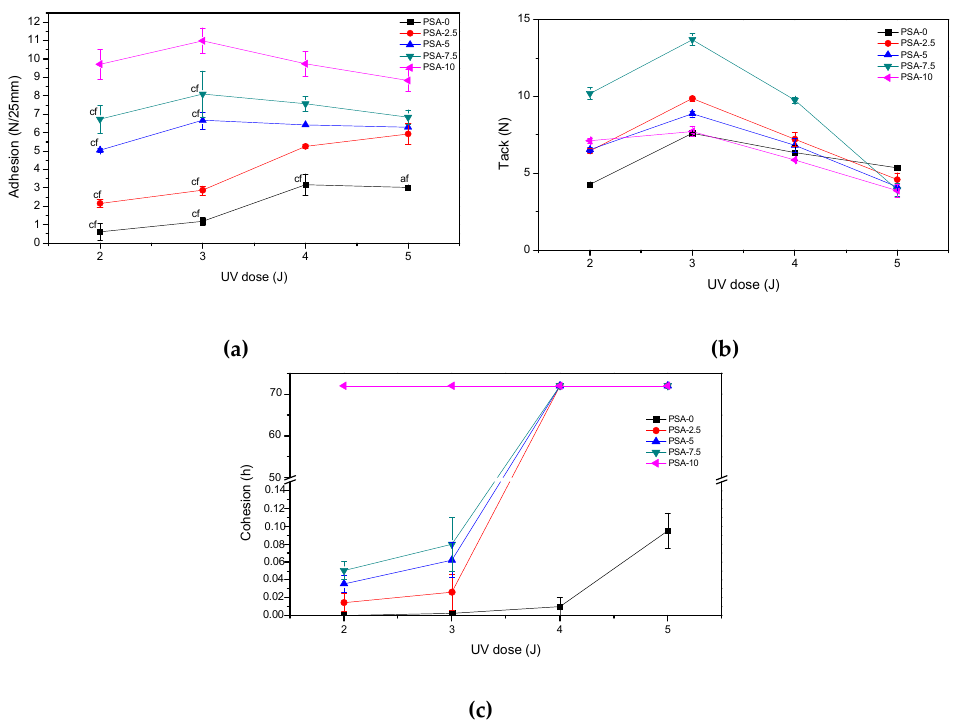
Figure 6. Self-adhesive features of PSAs based on BAA cotelomers: ( a ) adhesion to steel (cf-cohesive failure), ( b ) tack and ( c ) cohesion.